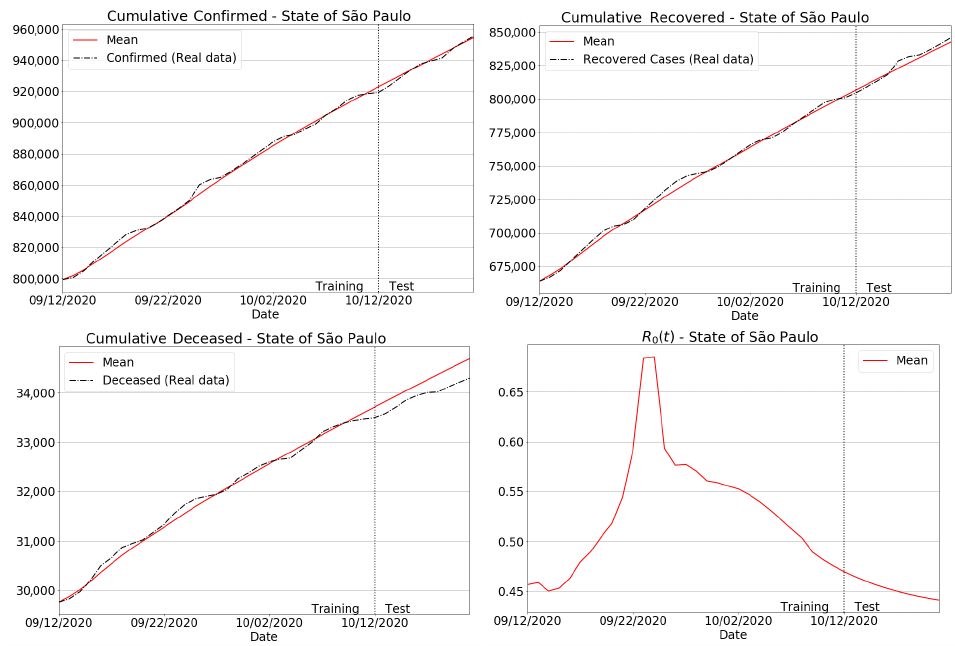
Figure 11. Forecasting results for São Paulo state.